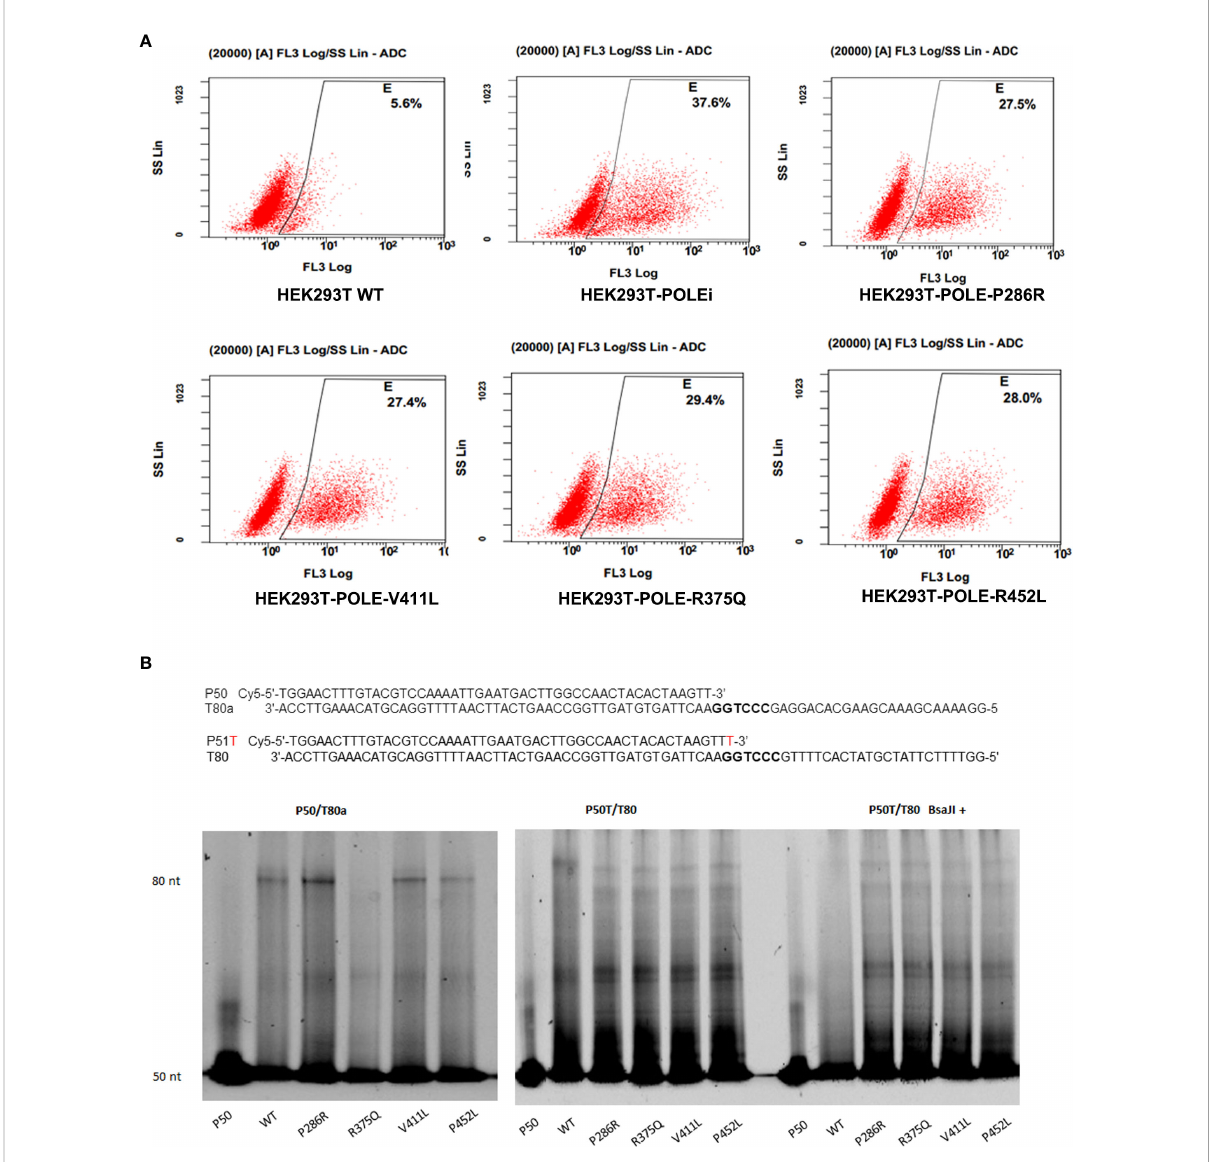
FIGURE 5 POLE EDMs impaired DNA mismatch repair in HEK293T cells. (A) HEK293T Cells were transfected with shPOLE, wildtype POLE , or POLE variants for 48 h, followed by fi xing with formaldehyde and incubation with T7 endonuclease 1 at 37 ˚ C for 45 min to cleave the mismatched base pairs. The produced 3 ′ -OH DNA ends were stained with TUNEL. Flow cytometry analysis was performed to quantify the mismatched base pairs. (B) Wildtype Pol ϵ or Pol ϵ mutants were incubated with the P50/T80a (left panel) or P51T/T80 (middle panel) substrate at 30 °C for 30 min. Right panel: Wildtype Pol ϵ or Pol ϵ mutants were incubated with P51T/T80 at 30 °C for 30 min, followed by BsaJI digestion. Urea polyacrylamide